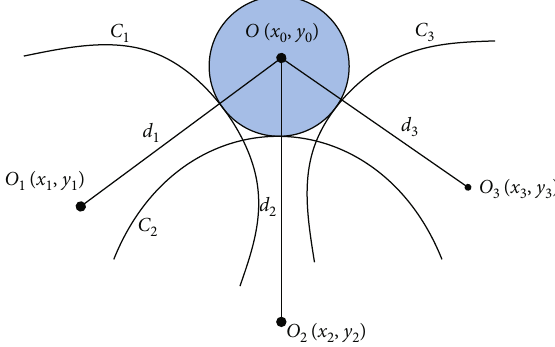
Figure 1: Principle of circular defect